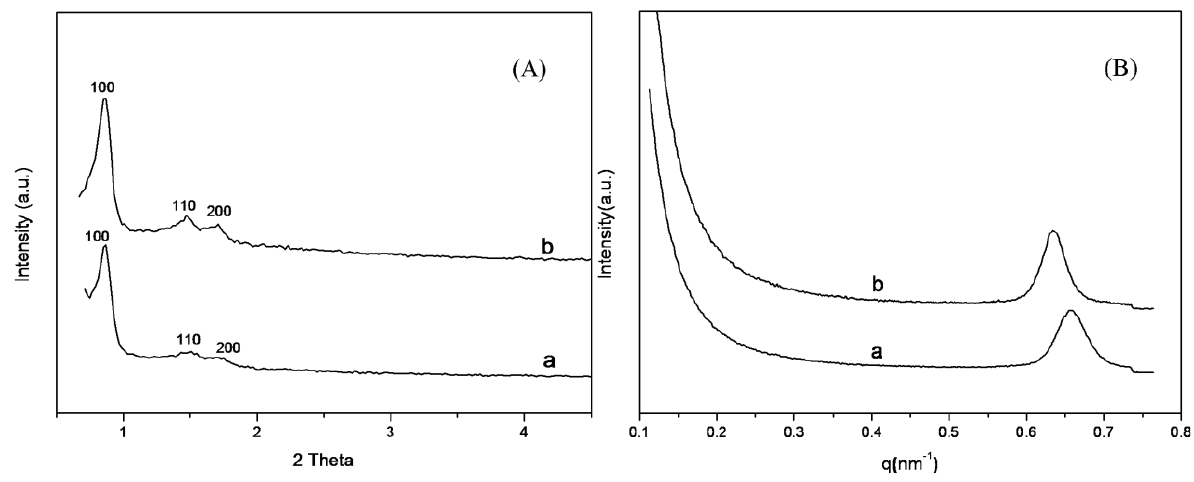
Figure 1. ( A ) X-ray diffraction (XRD); and ( B ) small-angle X-ray scattering (SAXS). Patterns of SBA-15-c and SBA-15-ex. a: SBA-15-c; b: